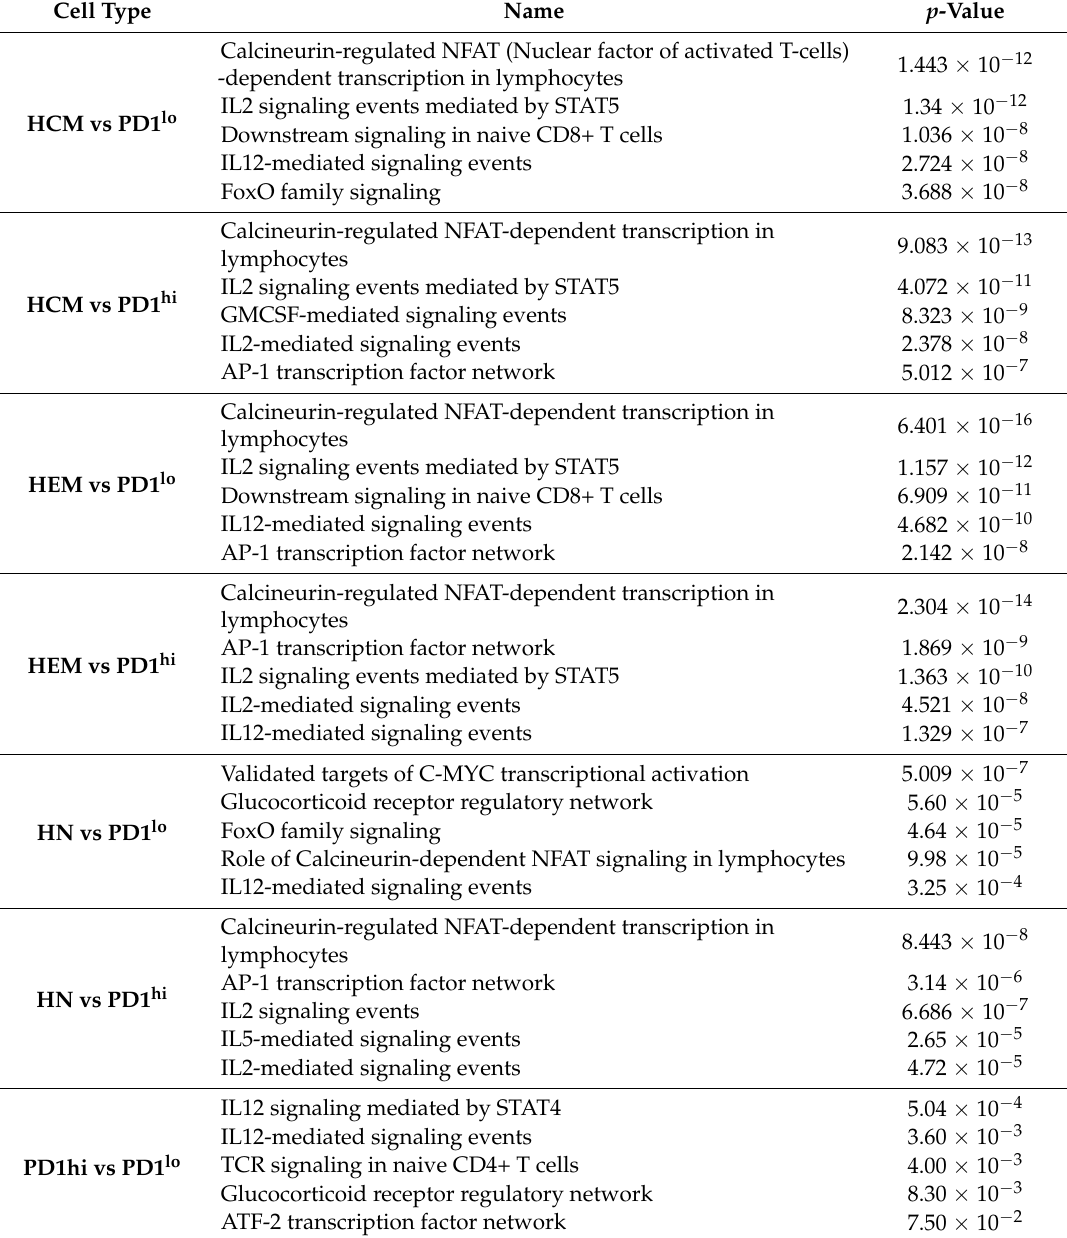
Table 4. Enriched specific signaling pathways in the differentially expressed genes between the T cells of healthy people and tumor infiltrating CD8 T